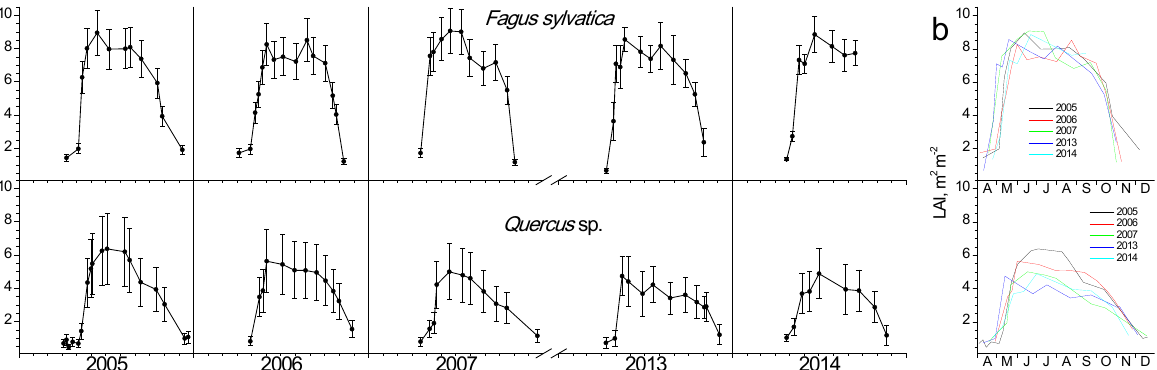
Figure 3. Seasonal fluctuation of leaf area index (LAI) for the two study sites. ( a ) Data for each year separately (average values ± SD for each date) ( b ) data for all years (only average values per date, error bars are not shown for clarity reasons).